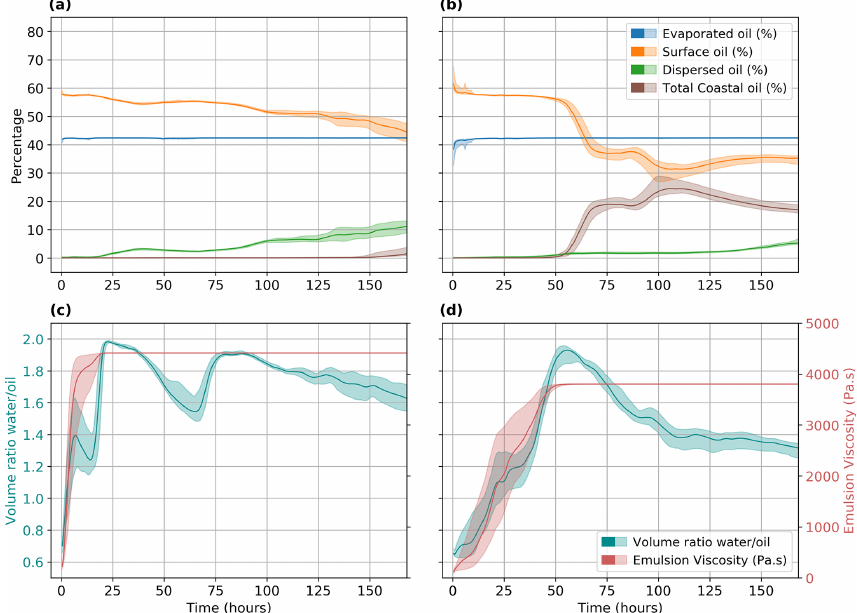
Figure 13. Fate parameters. Percentages (%) of evaporated, surface, dispersed (including sedimentation), and total coastal oil for (a) winter and (b) spring as a function of the forecast time. The volume ratio water / oil and emulsion viscosity (Pas) for (c) winter and (d) spring are shown. Colored solid lines represent the deterministic run and colored shaded areas represent the ensemble. Oil type: API